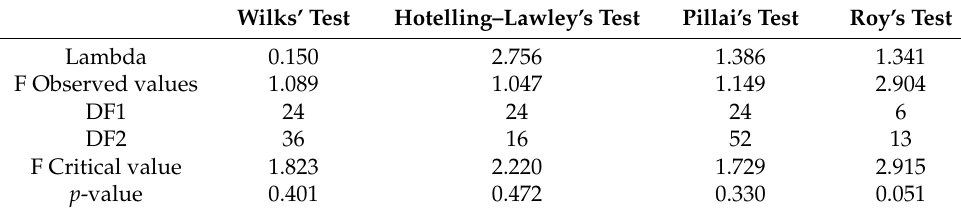
Table 1. MANOVA results of the coatings without crosslinker.